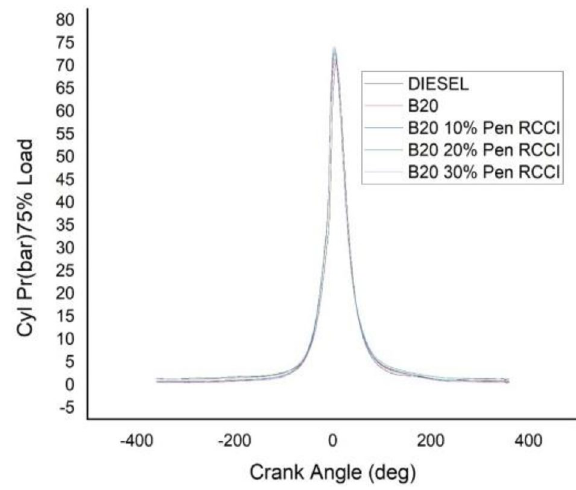
Figure 16. Cylindrical pressure at 75% load.